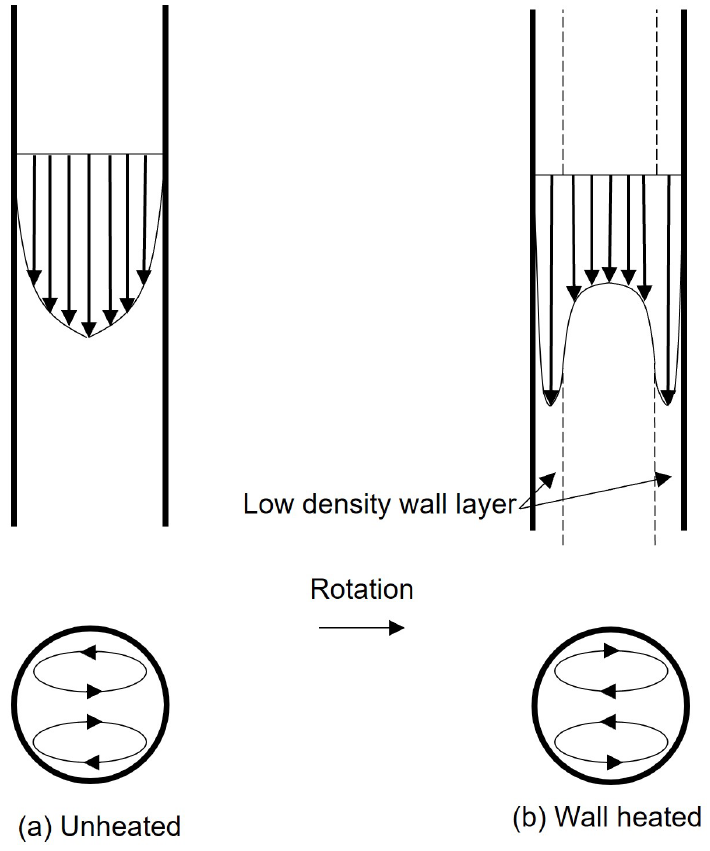
Figure 12. Secondary flows in an unheated/wall-heated rotating pipe.